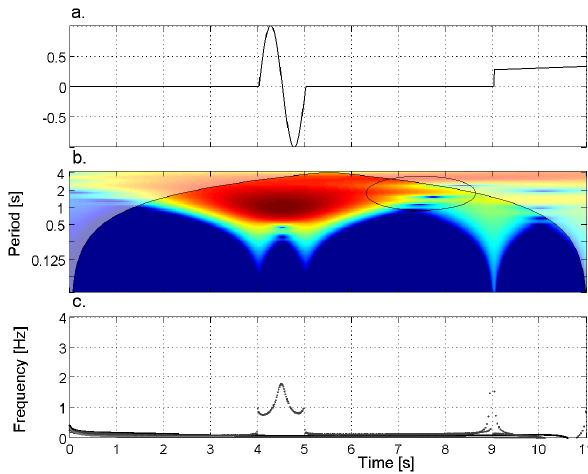
Fig. 1. (a) Test signal: sine wave + sudden jump; (b) Wavelet anal- ysis of the test signal; (c) Hilbert-Huang analysis of the test